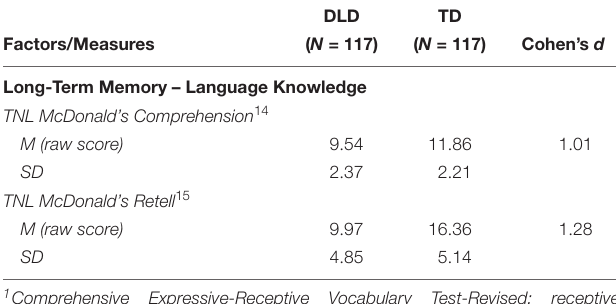
TABLE 1 | Performance on the language and cognitive measures for the children with developmental language disorder (DLD) and typically developing (TD) controls, and Cohen’s d (standardized mean difference) between the groups.